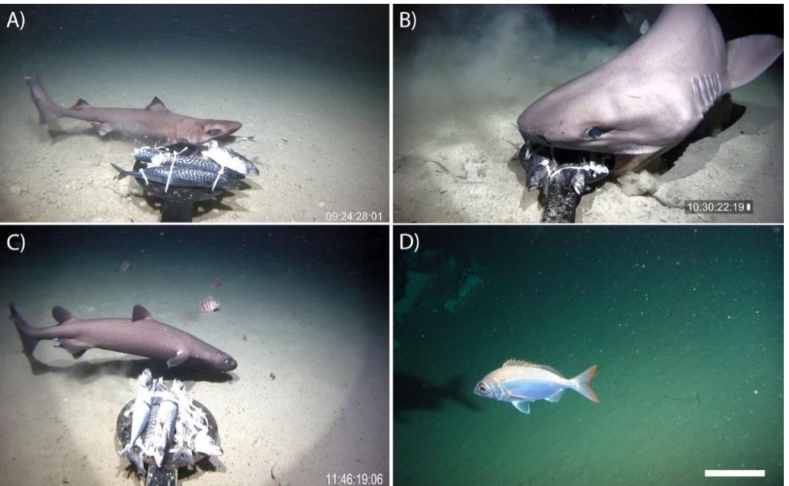
Figure 3. Examples of vulnerable cartilaginous and teleost fishes recorded in the Bari Canyon. ( A ) The critically endangered Centrophorus granulosus , ( B ) the bluntnose sixgill ( Hexanchus griseus ), which represents one of the most common sharks in the area and whose vulnerability is under minor consideration, and ( C ) the vulnerable Dalatia licha and in the background the blackbelly rosefish ( Helicolenus dactylopterus ), which represents one of the targeted deep-water species. The baited plat (diameter of 25 cm) is used for scale. ( D ) The common blackspot seabream ( Pagellus bogaraveo ) is one of the GFCM priority species, in the background, left side, note the Pachastrella monilifera ground. Scale bar = 15 cm. Table 2. List of organisms of conservation interest identified in the BC and the surrounding areas. Asterisks mark local and/or Mediterranean endemism; their threatened status is indicated when possible, as well the legal instruments under which the species are